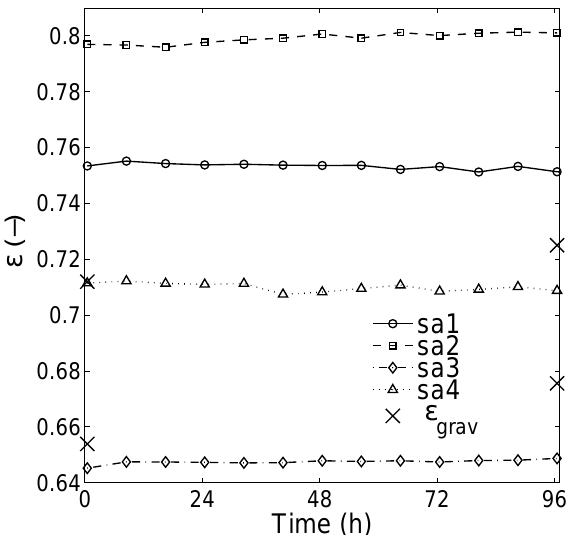
Figure 8. Evolution of the porosity over time obtained by triangu- lated structure surface method and the measured gravimetric density ( ε grav ) at the beginning and at the end of “sa3” and “sa4”.